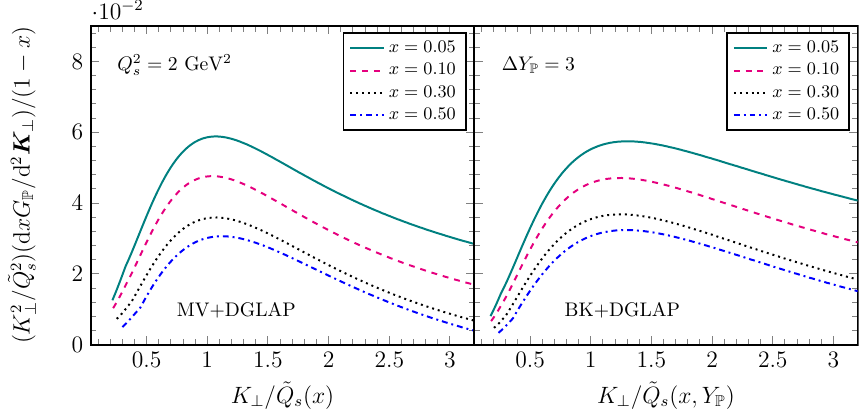
Figure 11 . The derivative of the Pomeron gluon distribution d xG solution to the DGLAP equation and scaled with [ K ⊥ / ˜ Q s ( x, Y of the rescaled momentum K ⊥ / ˜ Q s ( x, Y has been omitted. Left panel: the source term in the DGLAP equation is evaluated with the MV model. Right panel: the source also includes the BK evolution of the gluon dipole